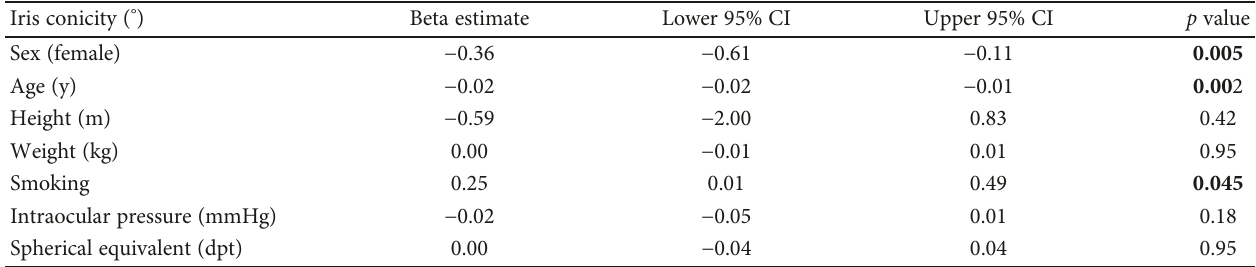
Table 2: Associationsofirisconicityandanthropometriccharacteristicsandintraocularpressure(IOP)andrefractionintheGutenbergHealth Study using a generalized estimating equation model to incorporate correlations between right and left eyes. CI: con fi dence